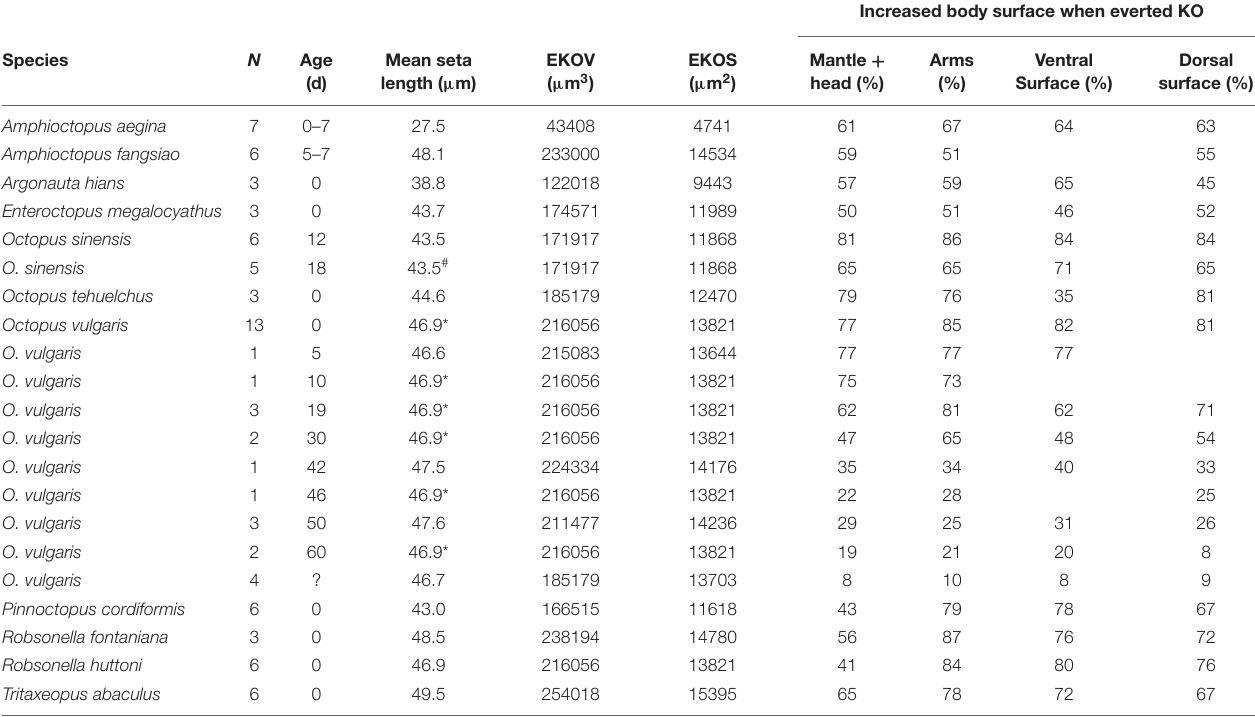
Increased body surface when everted